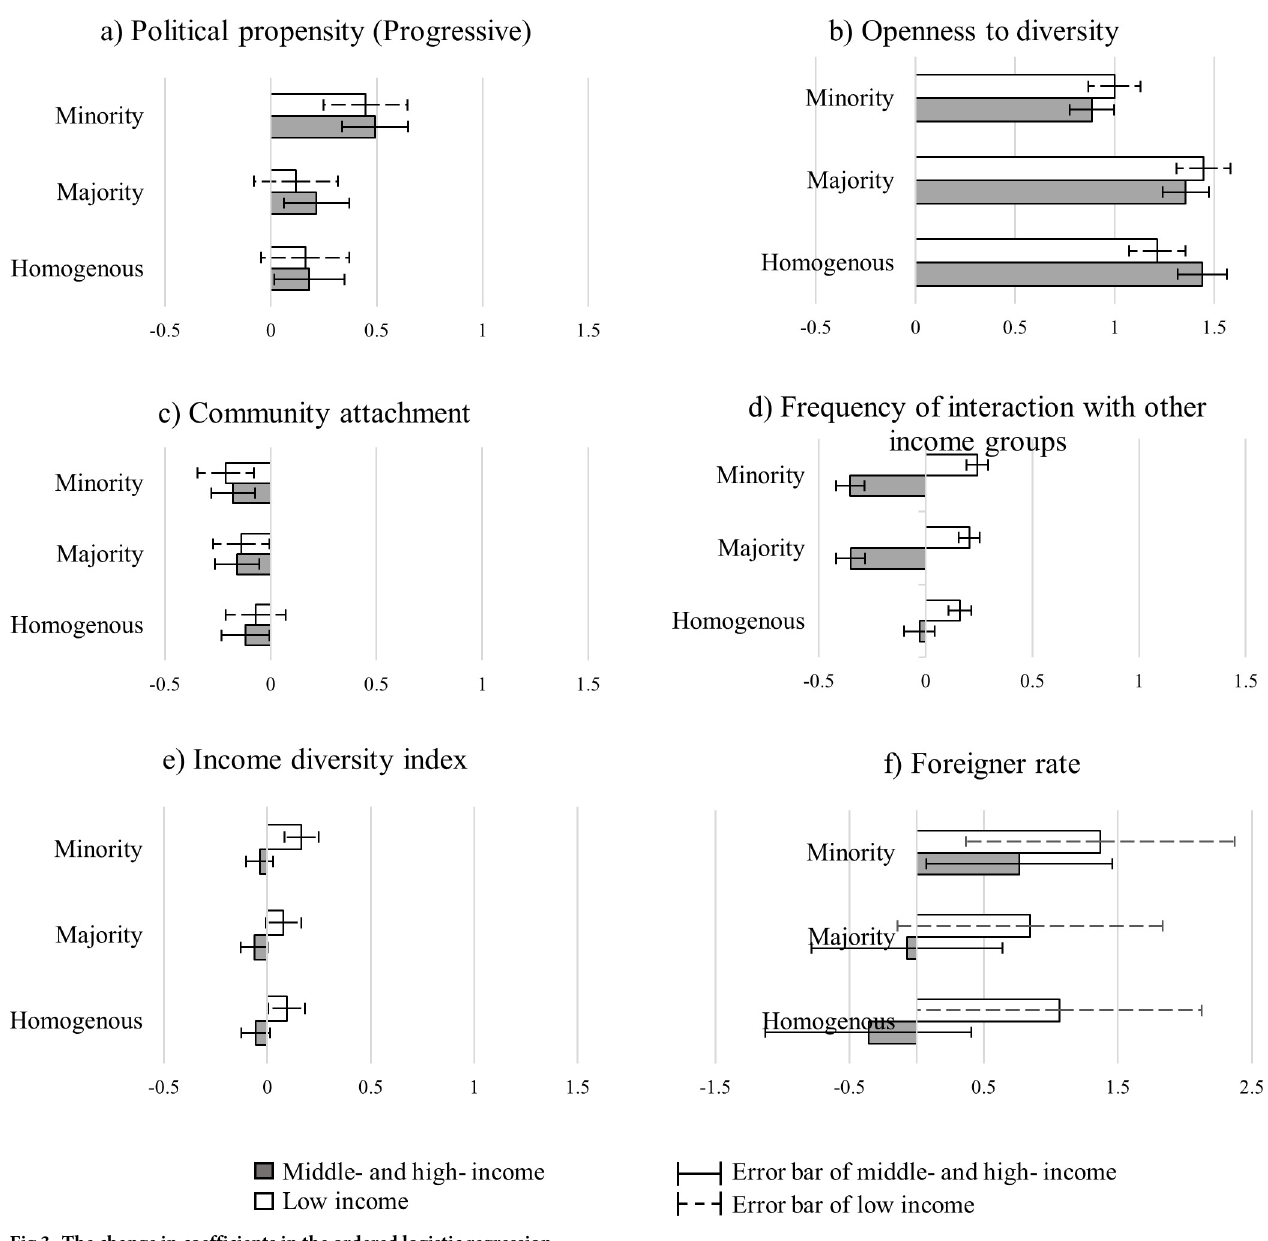
Fig 3. The change in coefficients in the ordered logistic